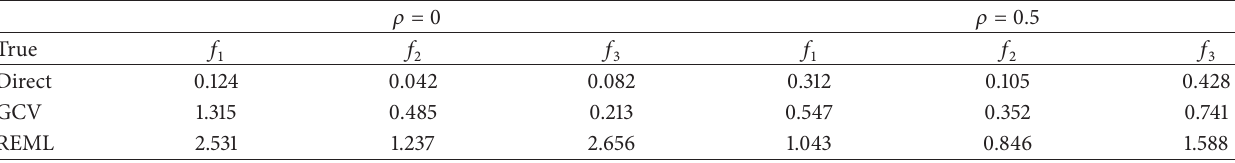
Table 5: Results of sample MSE of the selected smoothing parameter via direct method, GCV, and REML for 𝜌 = 0 and 𝜌 = 0.5 . All entries for MSE are 10 2 times their actual values.